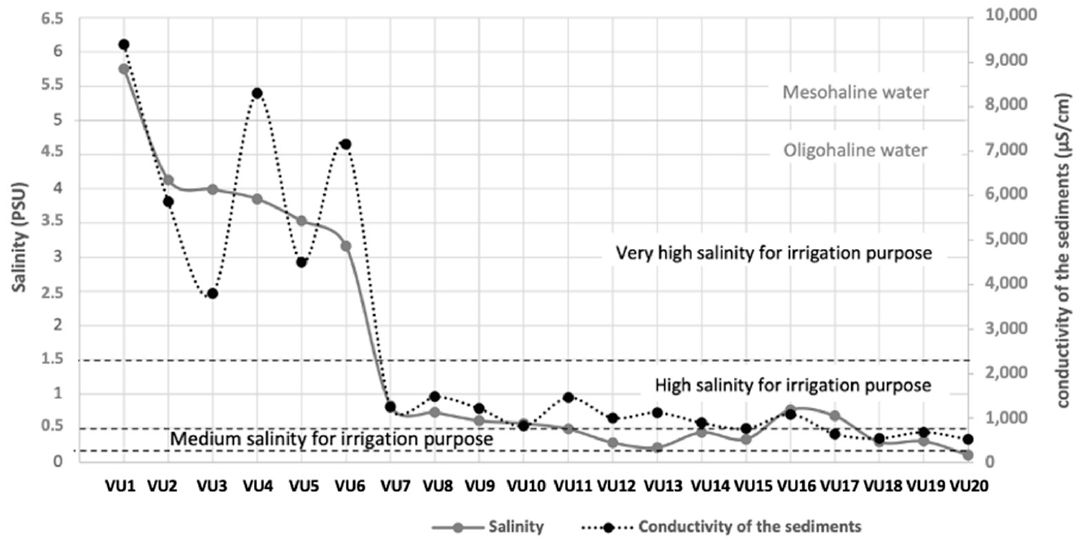
Figure 3. Salinity and sediment conductivity variations along the Van Uc River . Table 2. Abiotic properties (mean ± SD, min.–max.) of sampling stations representing three habitats along the Van Uc River. T w — water temperature, T s — sediment temperature, DO — dissolved oxygen, pH w — pH of water, pH s — pH of sediment, D (50) — median particle size, TN — total nitro- gen, TP — total phosphorus, OM — organic matter, ECs — pore water electrical conductivity, PSU— practical salinity unit.